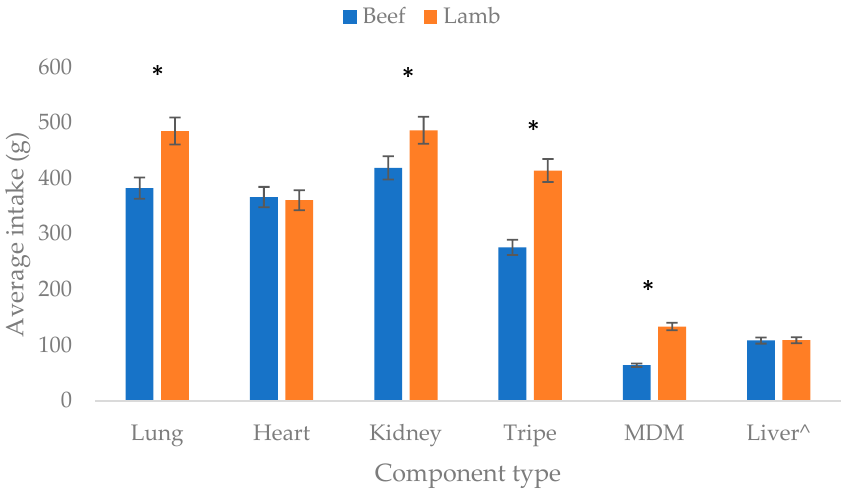
Figure 3. Average intake of equivalent beef and lamb components offered in the two-bowl preference test. (Results with an asterisk indicate a significant difference in intake between equivalent components ( p < 0.05), ^ maximum possible intake of each liver was 113.5 g compared to 500 g for the other components).